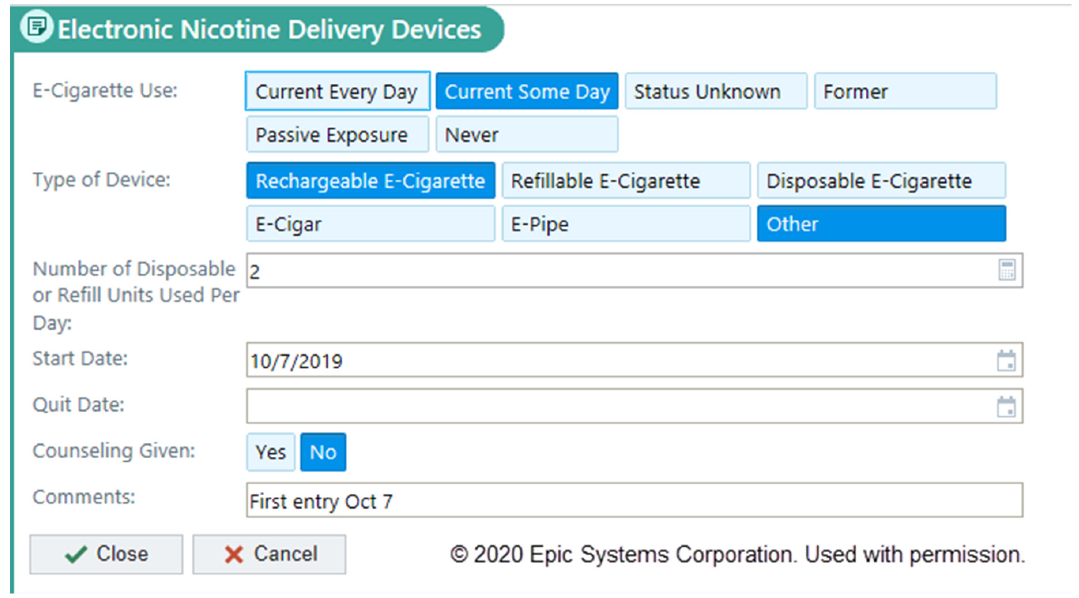
Figure 1. New electronic health record documentation framework to record the e-cigarette use information collected from patients during ambulatory appointments.